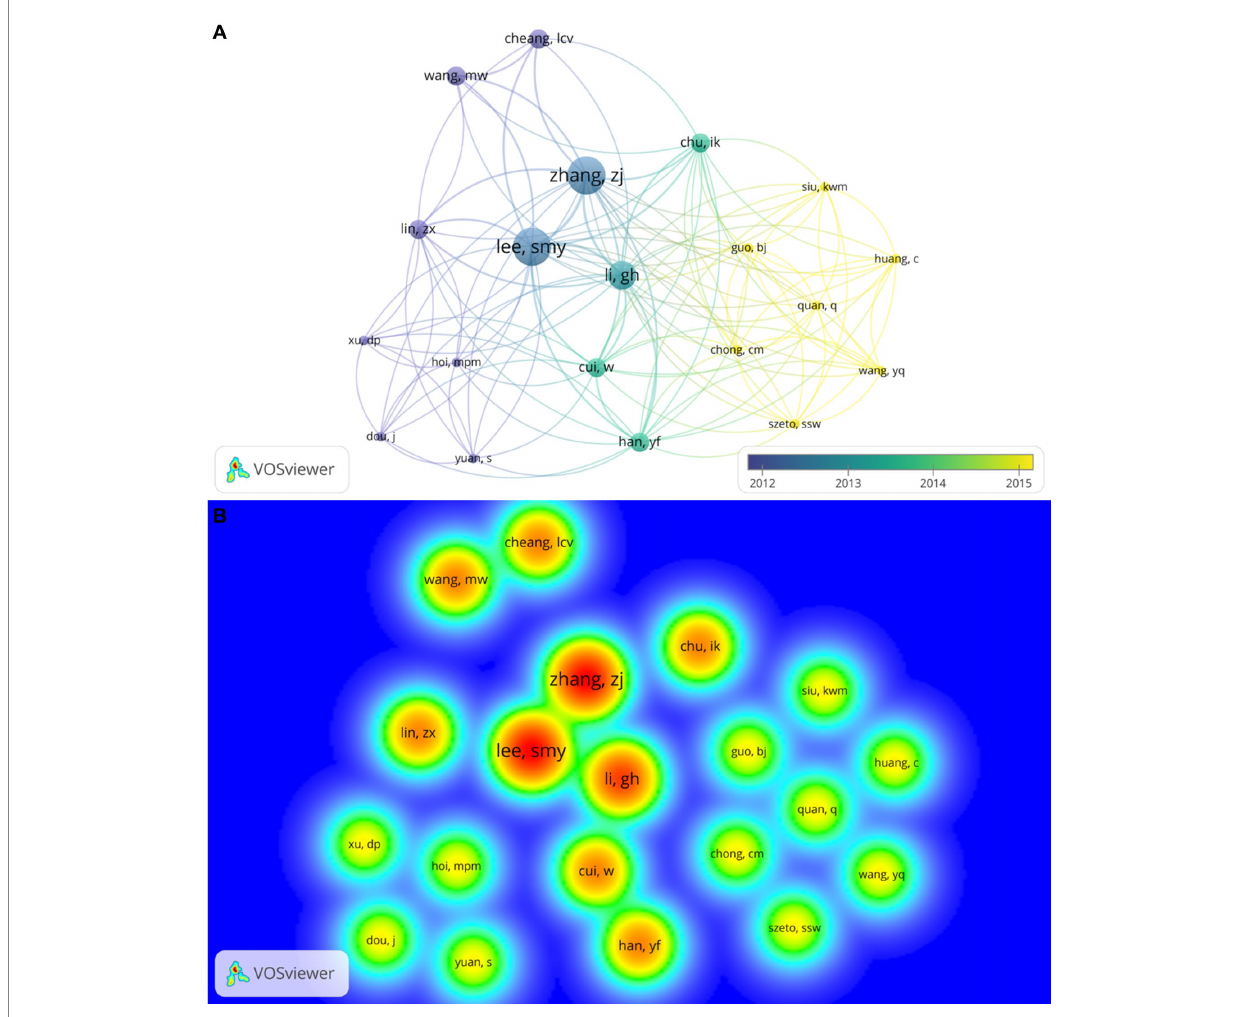
FIGURE 3 The cluster with the highest number of publications. (A) The cluster is composed of 20 authors. The period of publication of the cluster’s papers is indicated by the color scale that varies from blue (2012) to yellow (2015). The node size represents the citation number of each author. The authors who collaborated in publications that occurred between the years 2012–2013 have higher numbers of citations compared to the authors who collaborated with publications that occurred between the years 2014–2015. The number of citations contributes to the strength of the connection between the authors represented by the distance between the authors. Authors with higher numbers of citations have higher binding strength. This representation suggests that the articles published by the cluster in the period 2012–2013 have higher numbers of citations. (B) The authors who make up the cluster with the highest number of publications are represented by heat islands demonstrating the citation density (number of citations/year of publication). The size of the heat island corresponds to the citation density. Authors with high citation density are closer, suggesting that publications that occurred in collaboration between them have higher numbers of